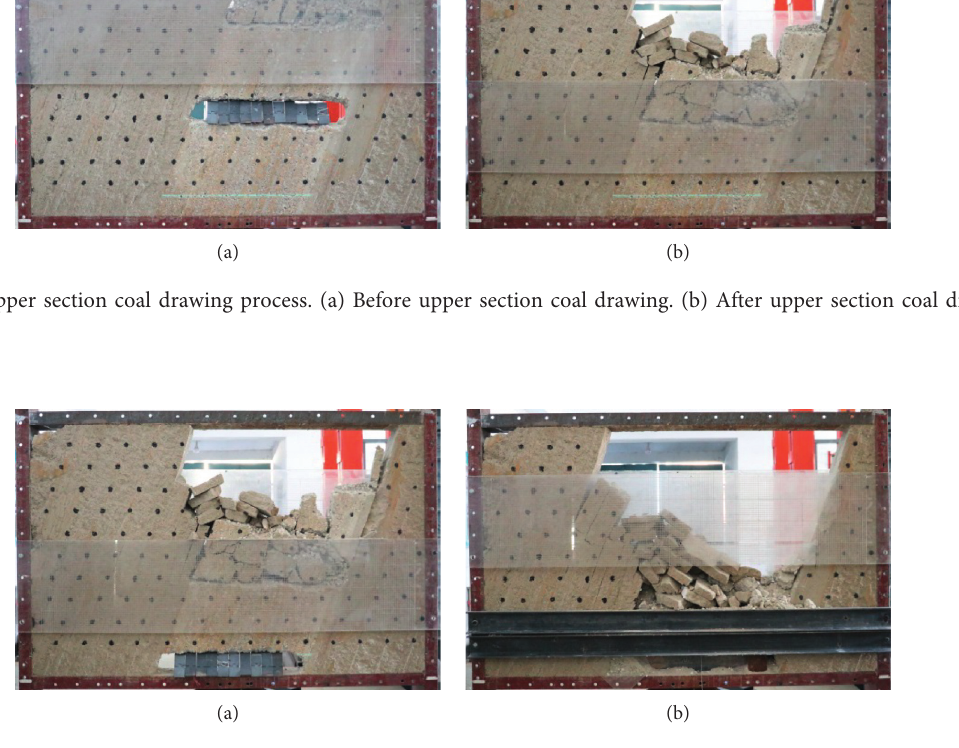
Figure 9: Lower section coal drawing process. (a) Before lower section coal drawing. (b) After lower section coal drawing.